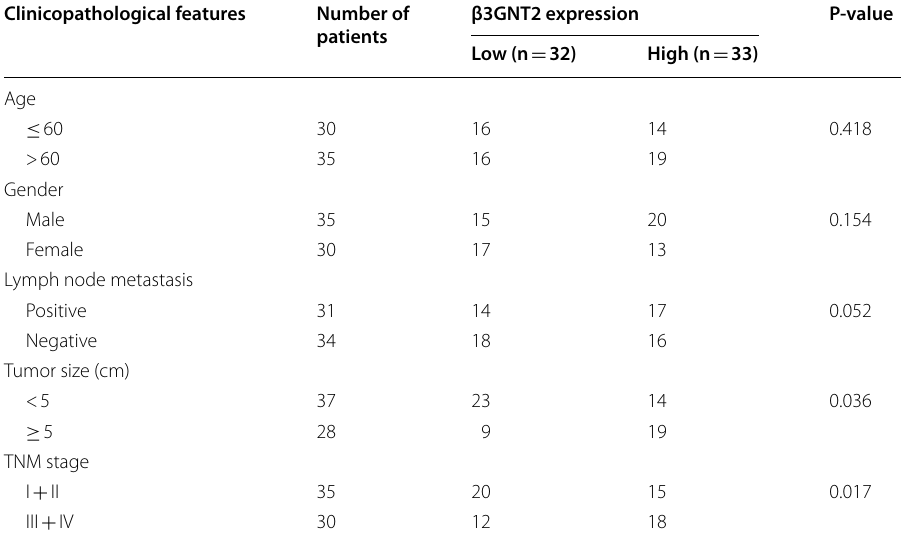
Table 2 Relationship between β3GNT2 expression and clinicopathological features of ESCA patients Clinicopathological